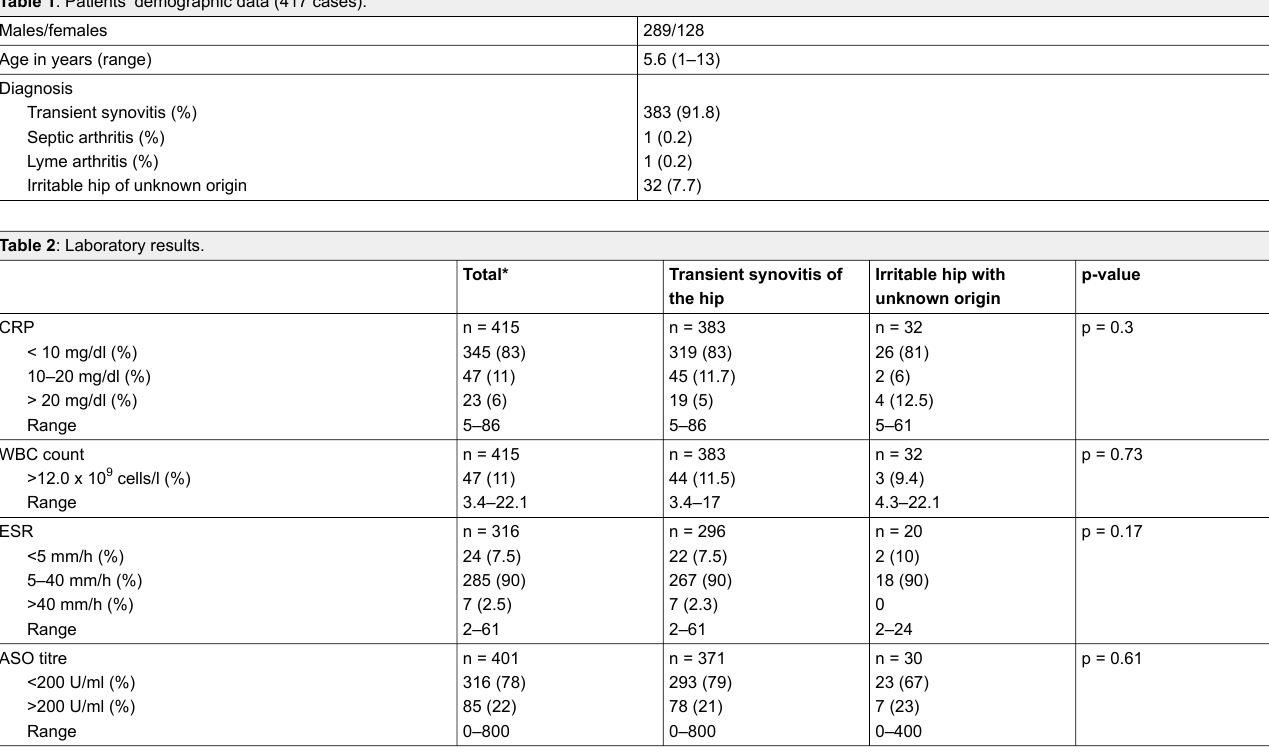
Table 2 : Laboratory results.